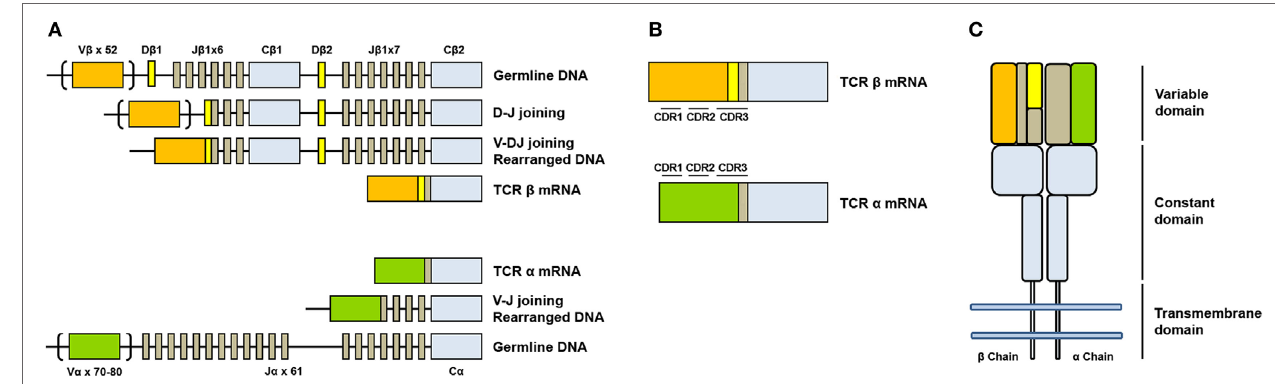
FigURe 1 | Somatic V(D)J arrangement in the alpha and beta chains. (A) Genomic organization and somatic recombination of TCRB and TCRA loci. Antigen repertoire diversity is guaranteed by a recombination step that progressively rearranges V, D, and J segments for T cell receptor (TCR) beta chains and V and J segments for TCR alpha chains. This variability (combinatorial diversity) is further increased by addition or deletion of nucleotides at the junction sites (junctional diversity). (B) Productive arrangements of beta and alpha transcripts. (C) Organization of TCR. TCR is composed by two subunits TCR alpha and TCR beta each organized in a constant region and a variable region responsible for antigen